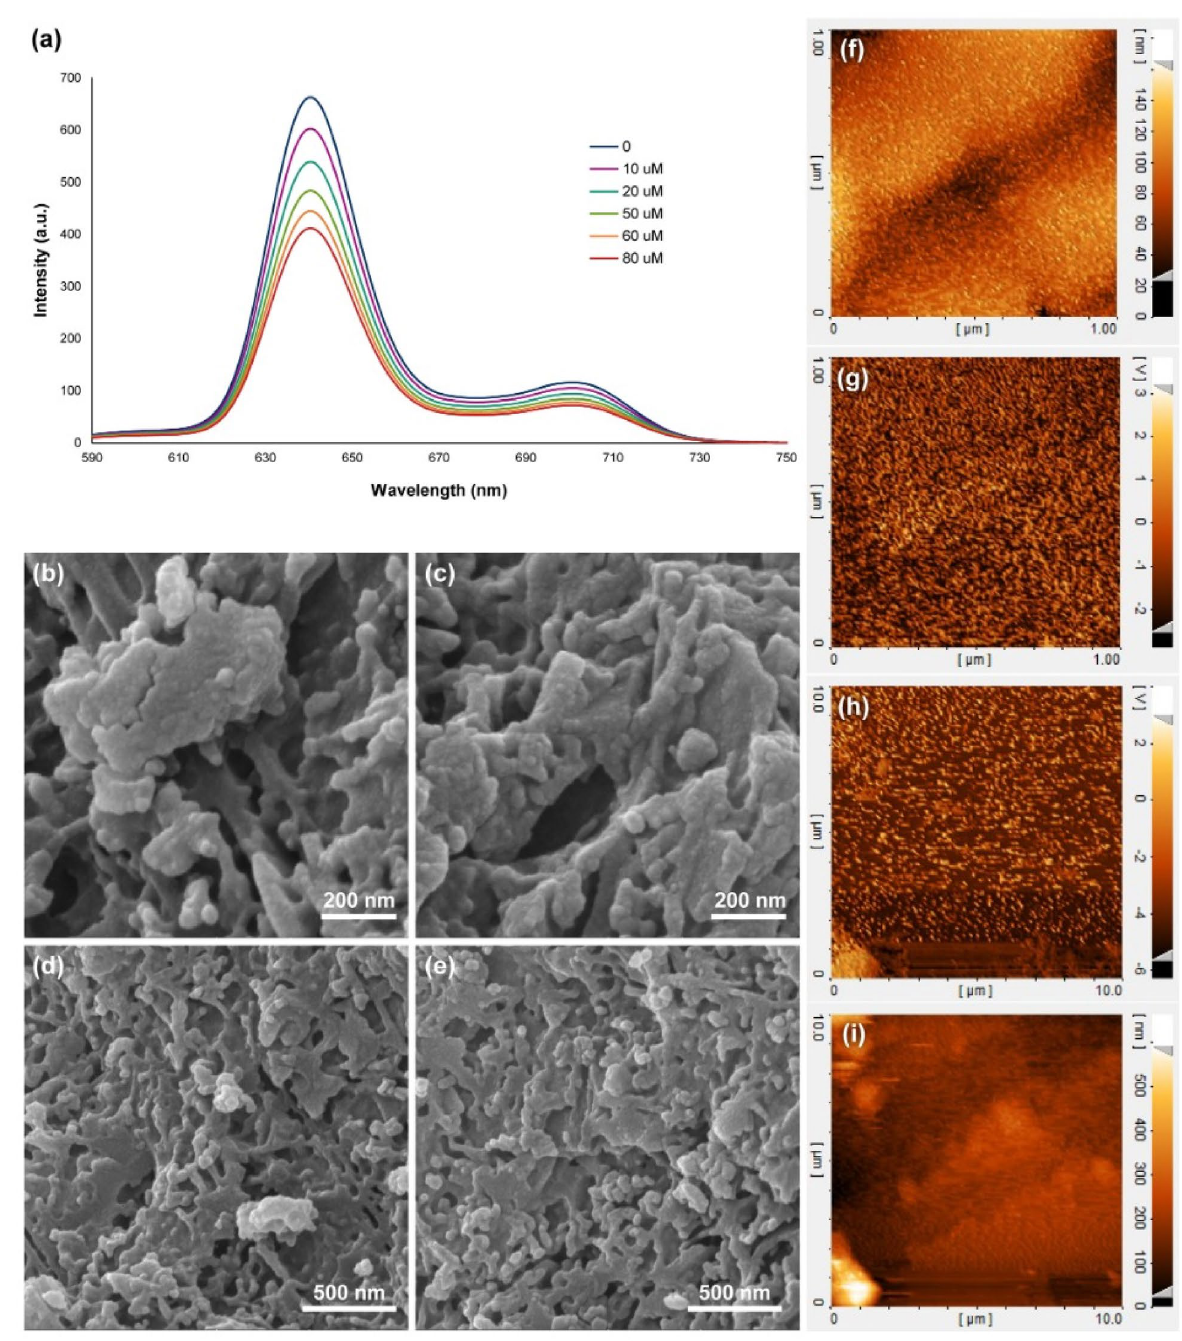
Figure 3. Fluorescence emission spectra of the synthesized 3D nanocomposite in the presence of different concentrations of hydrogen peroxide ( a ), FESEM ( b – e ), and AFM ( f – i ) images of the synthesized 3D nanocomposite after exposure to the hydrogen